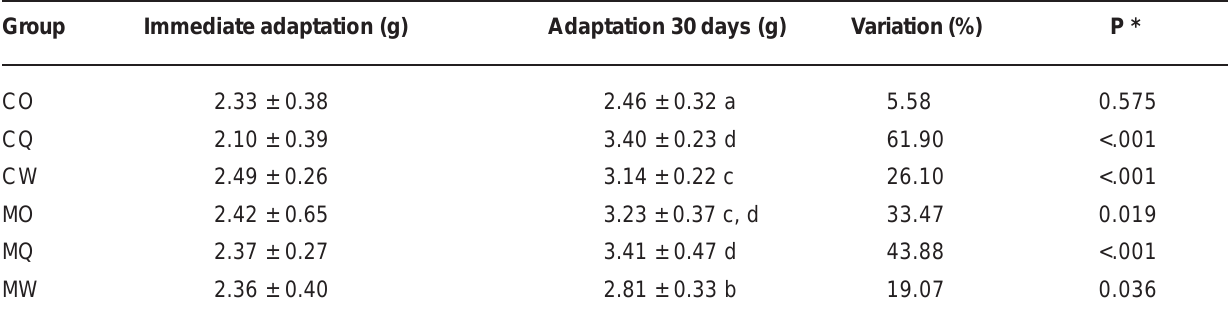
Immediate adaptation: No significant difference between groups at the significance level of 0.05. Adaptation 30-days: Means followed by different letters are statistically different at α =0.05. * Paired Student´s t test for Immediate adaptation versus Adaptation 30 days, α